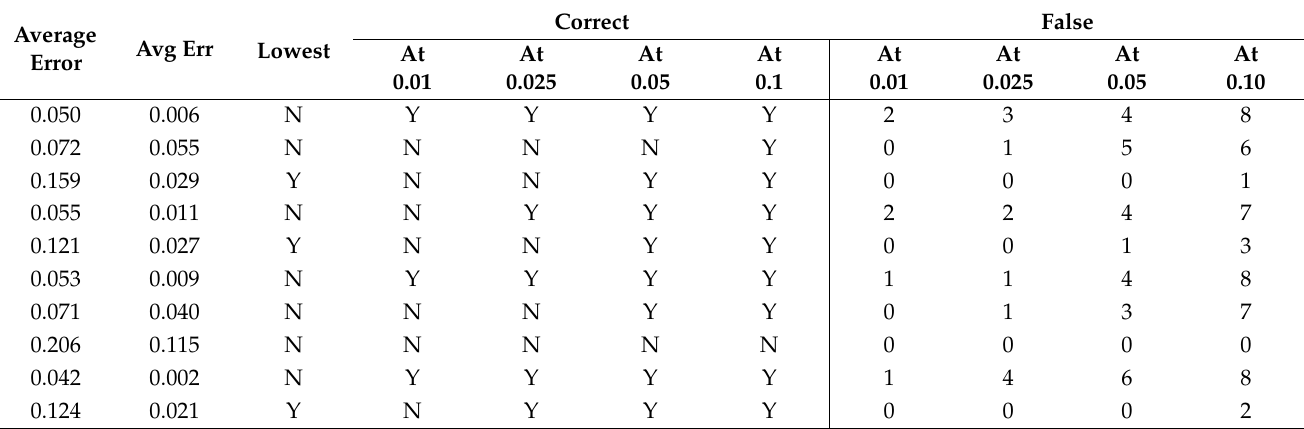
Table 6. Set 2, trials 21–30 summary data (actual PR value).